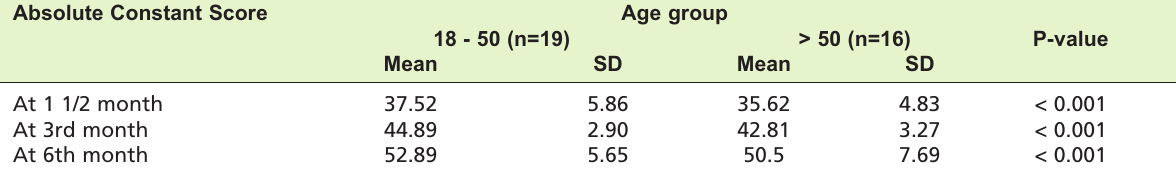
Absolute constant score vs age of Table VI: